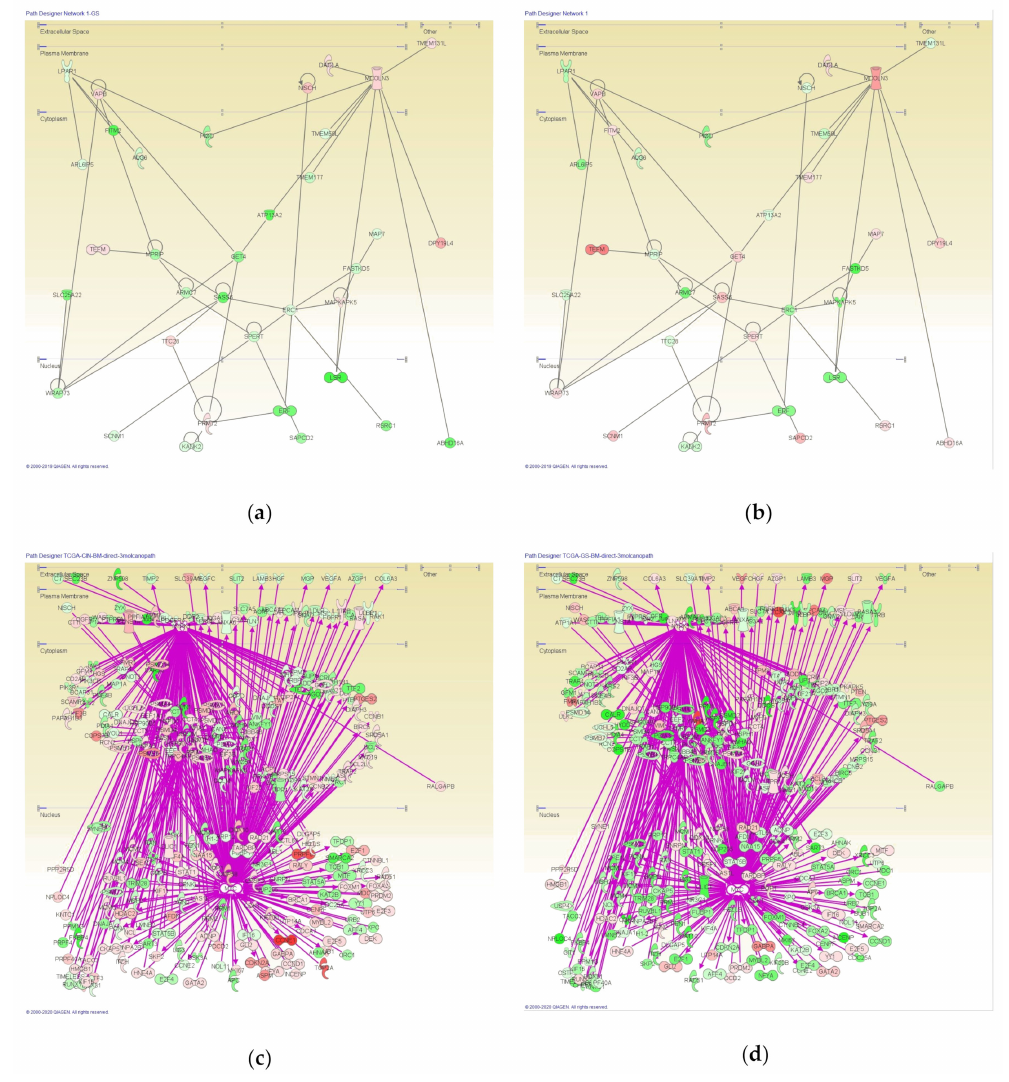
Figure 2. Networks generated from genes altered in intestinal- and di ff use-type gastric cancer (GC). A total of 2815 IDs, which had significant di ff erence between intestinal- and di ff use-type GC, were analyzed in Ingenuity Pathway Analysis (IPA); and Network 1 related to cancer, gastrointestinal disease, organismal injury and abnormalities is shown. ( a ) Network in intestinal-type GC; ( b ) Network in di ff use-type GC. A total of 463 direct relationships with three molecules (MYC, NTRK1, UBE2M) are shown in the network of biomarker-filtered genes in intestinal-type GC ( c ) and di ff use-type GC ( d ). From 613 genes biomarker-filtered (human, blood, cancer), 285 genes including MYC, NTRK1 and UBE2M are included in the network. All relationships were